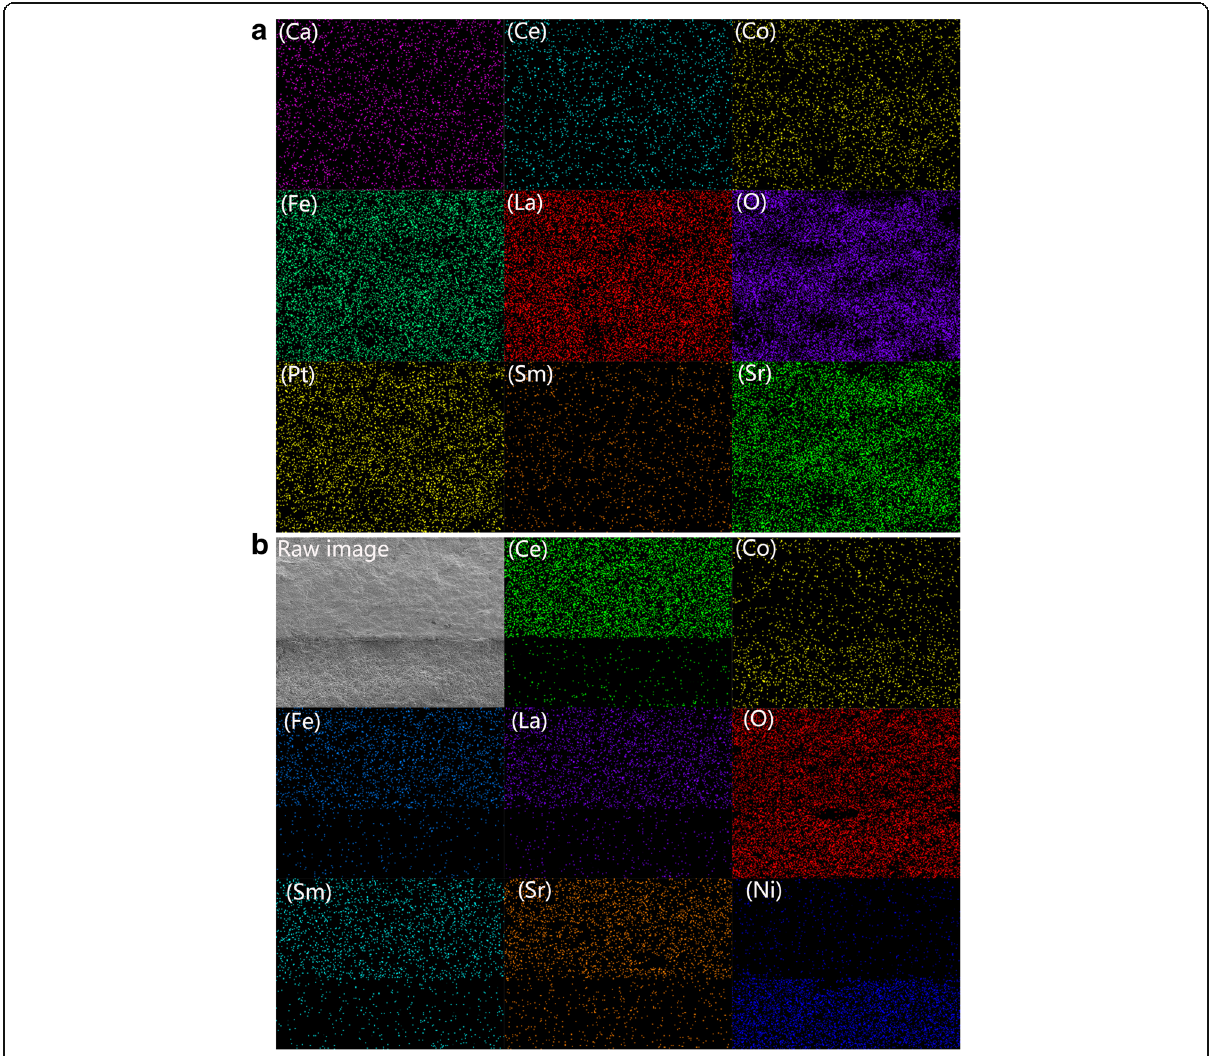
Fig. 3 a EDS mapping images of the LSCF-SCDC pellet sintered at 1000 °C. b The cross-sectional SEM image and element mapping for the interface between LSCF-SCDC membrane and NCAl